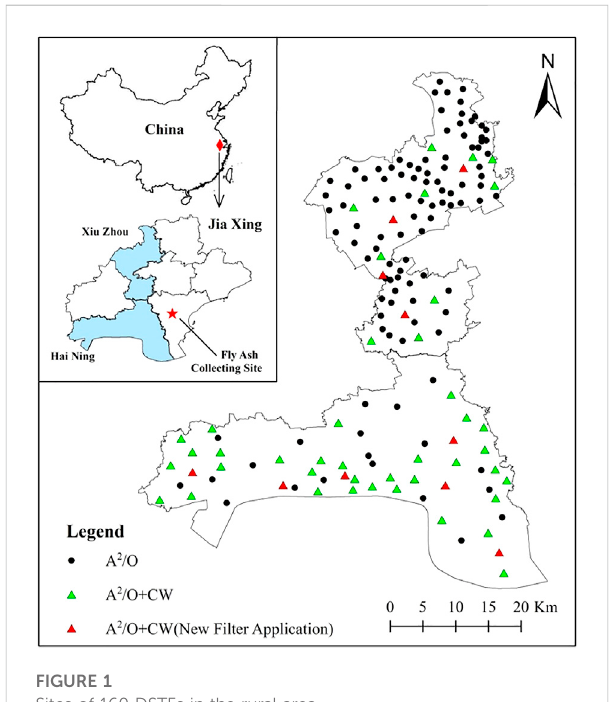
FIGURE 1 Sites of 160 DSTFs in the rural